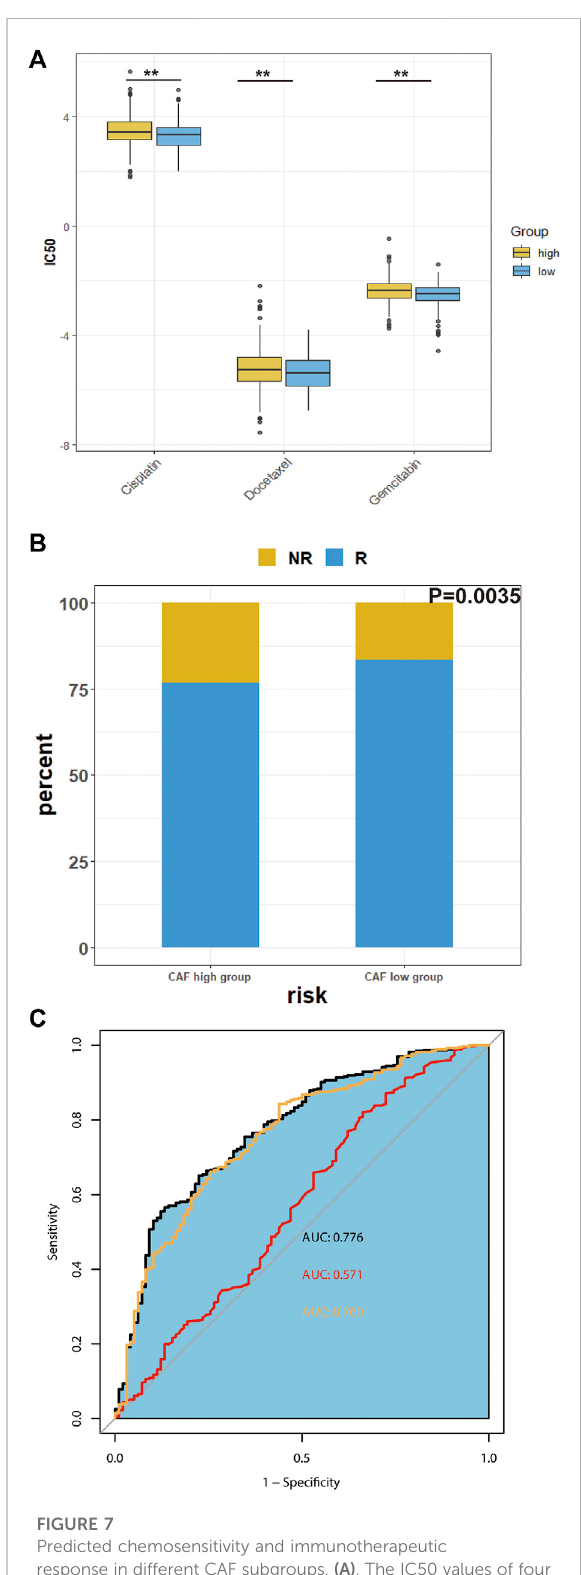
FIGURE 7 Predicted chemosensitivity and immunotherapeutic response in different CAF subgroups. (A) , The IC50 values of four anti-cancer drugs of different CAF-subgroup of TCGA-HNSC patients predicted by pPRophetic algorithm. (B) , Predicted